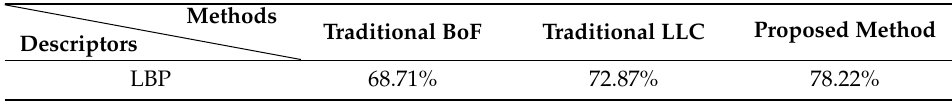
Table 2. Classification accuracies based on Local Binary Pattern (LBP).